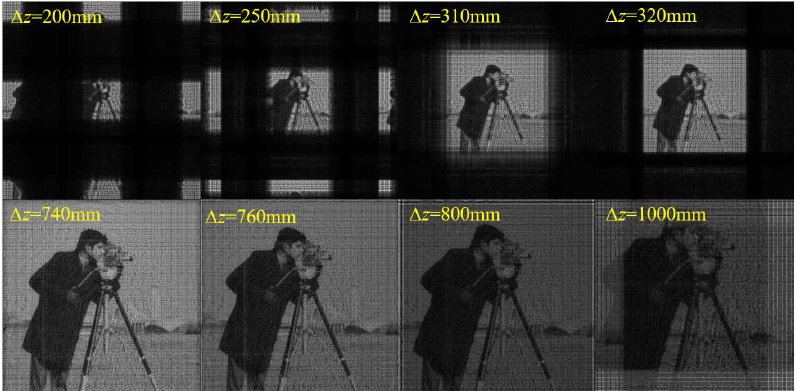
Figure 5. Calculated amplitude distributions on the diffraction plane with different ∆ z using SASM.